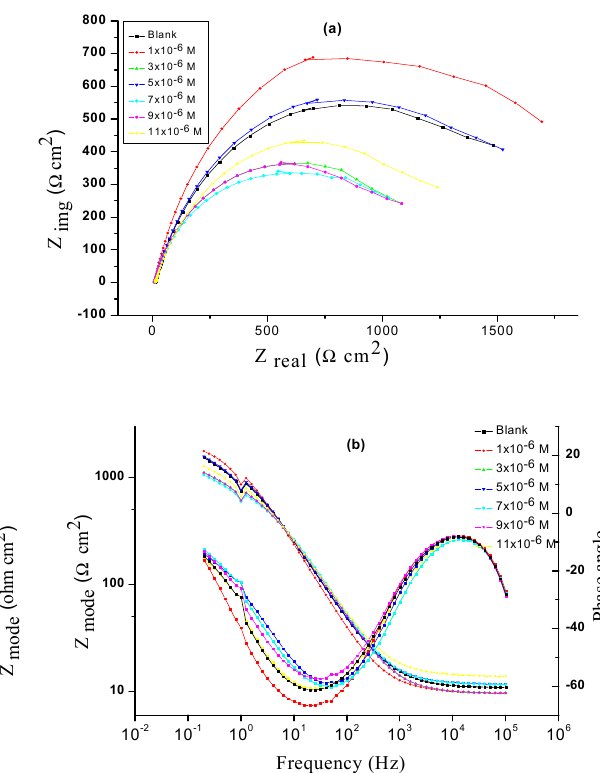
Figure 2. EIS Nyquist ( a ) and Bode diagrams ( b ) for the corrosion of Q235 steel in attendance and lack of unlike dose of compound (1) at 25 ± 0.1 °C.